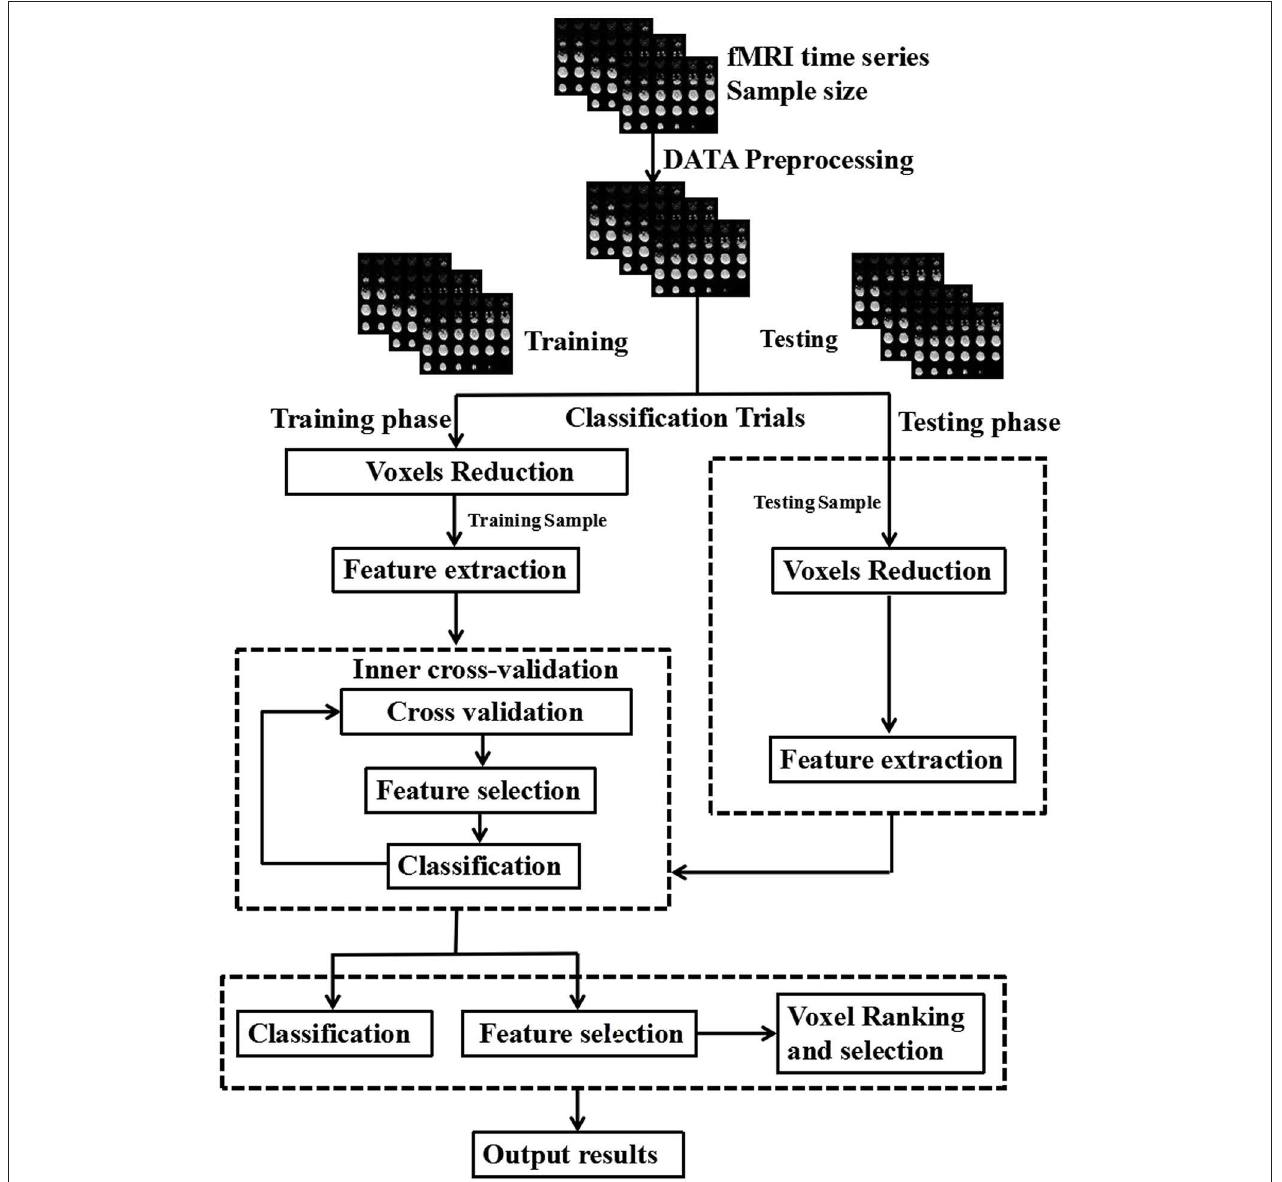
FIGURE 1 | Schematic diagram overview of machine learning classification framework. The inner cross-validation was used to determine the optimal number of features and the outer cross-validation was employed to estimate the classification performance.